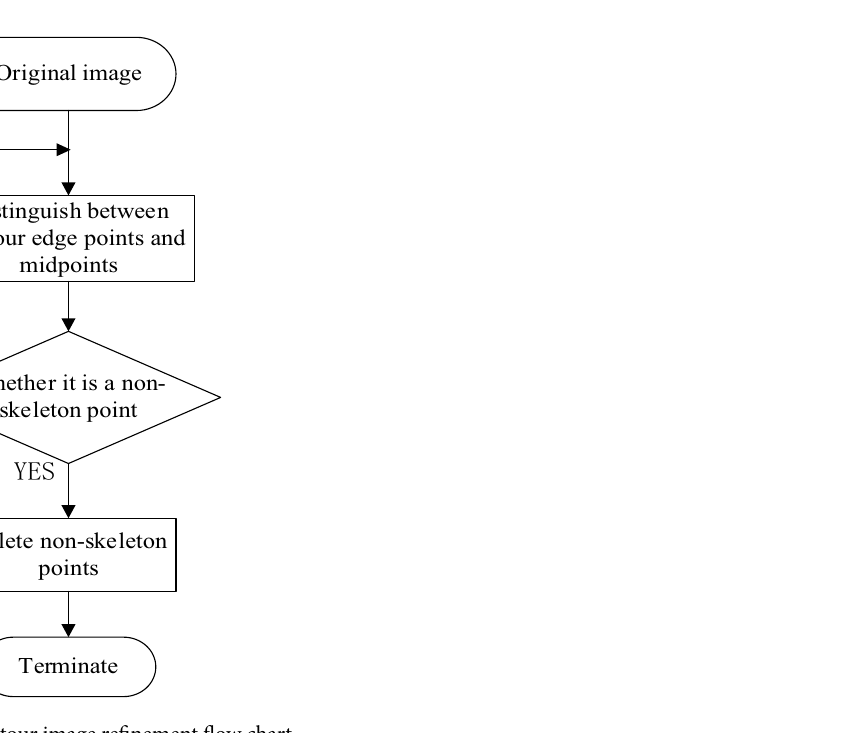
Figure 4. Contour image refinement flow